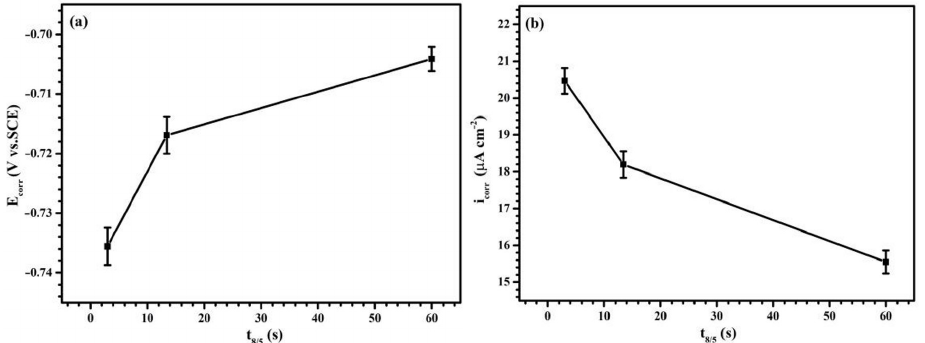
Figure 16. Fitting results of E corr ( a ) and i corr ( b ) for the ICCGHAZs with different cooling rates in 3.5 wt% NaCl solution.